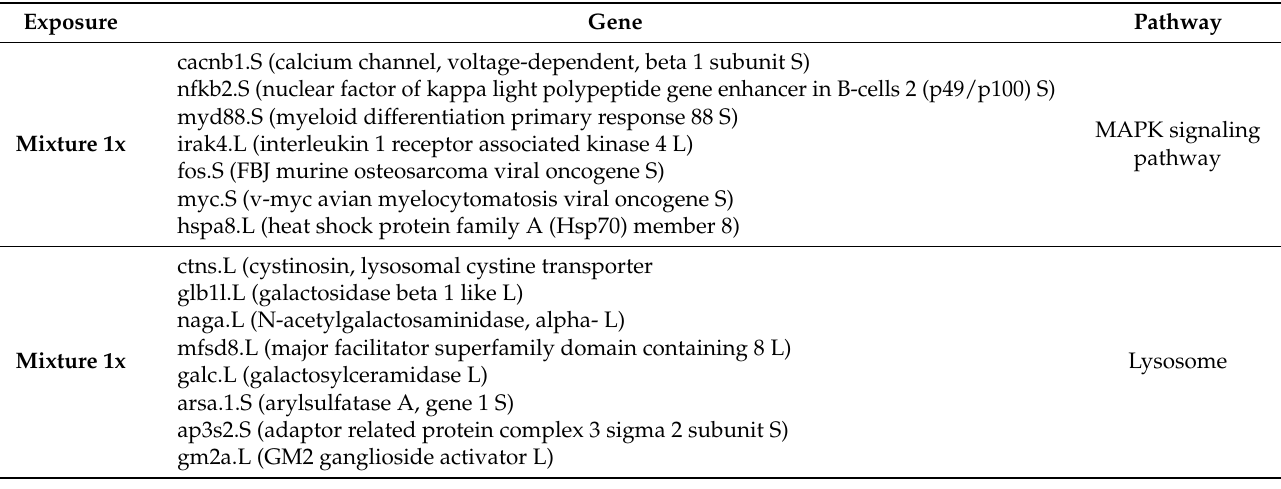
Table 2. KEGG pathway analysis of target genes after mixture and TH exposure. Target genes up-regulated or down-regulated that were annotated for neuroactive ligand–receptor interaction under T 4 (10 nM) exposure, and the MAPK signaling pathway and lysosome activity under mixture exposure (Amnios 1x).